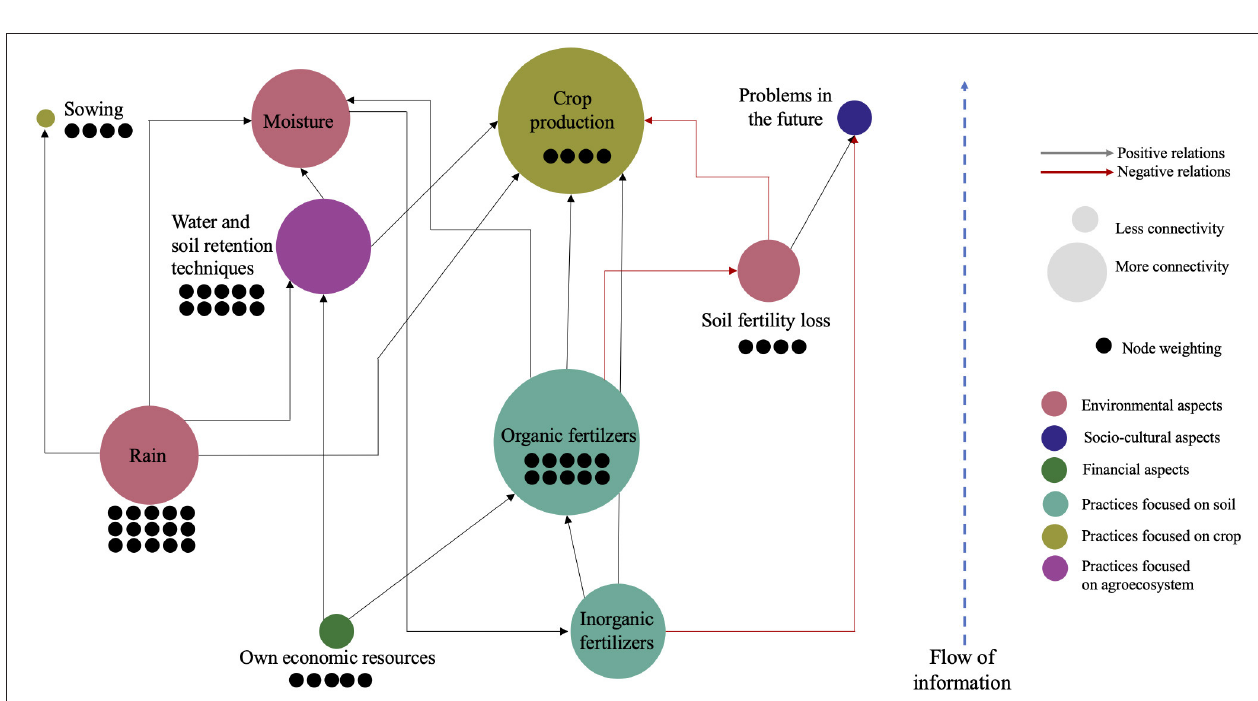
FIGURE 5 | Top ten nodes for the MBP CM based on centrality measures. The size of the nodes corresponds to connectivity (the bigger the node, the more connections it has). Black dots represent the weighting scores.